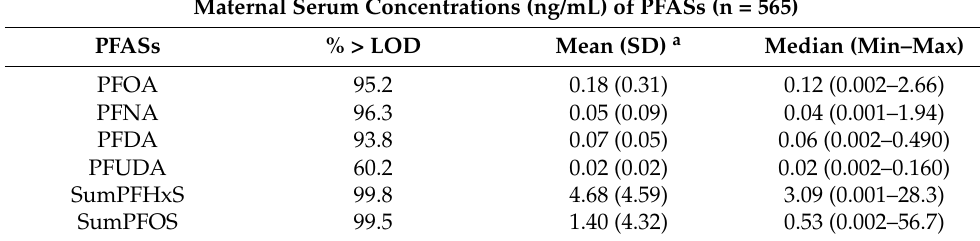
Table 2. Maternal serum concentrations (ng/mL) of